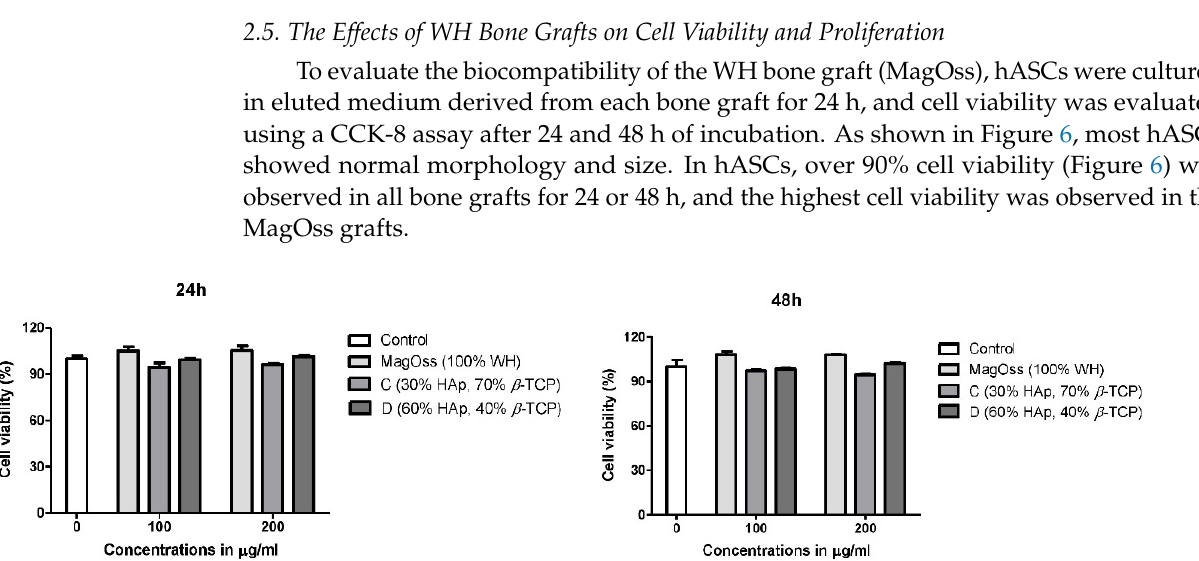
Figure 5. Analysis of the amount of Mg 2+ , Ca 2+ , and P + ions released (as ions related to osteogenic differentiation).